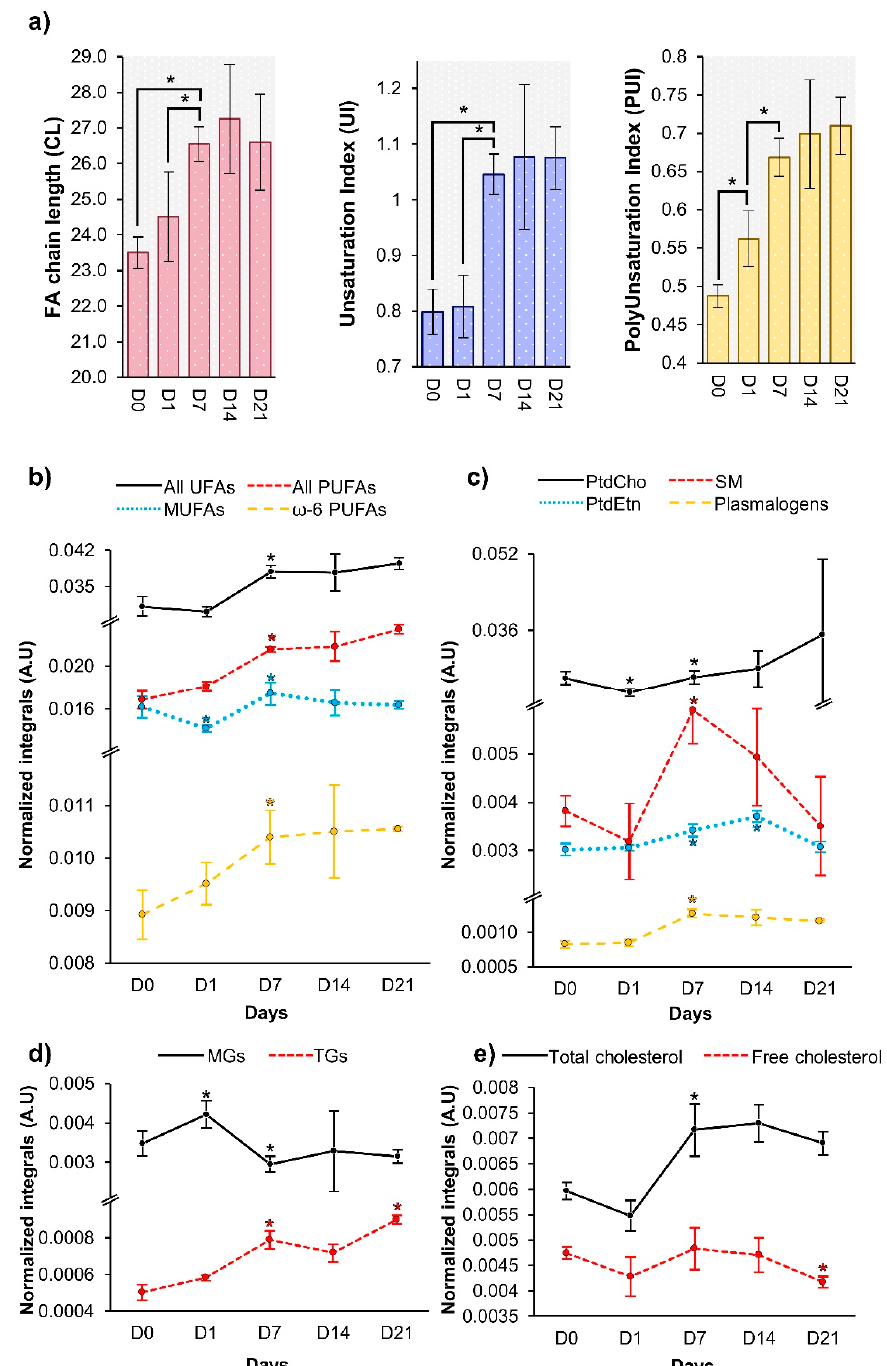
Figure 5. Average lipid characteristics ( a ) and level fluctuations ( b – e ) of lipid species/classes selected in Figure 4. ( a ) Average fatty acid chain length, unsaturation index and polyunsaturation index were calculated according to [55]. Normalized integrals of lipids during the 21 days of osteogenic differentiation, including ( b ) fatty acids, ( c ) glycerophospholipids and sphingomyelins, ( d ) cholesterol, and ( e ) glycerolipids. Abbreviations as defined in Figure 2. Di: day i; *: Wilcoxon Rank-sum p- value < 0.05 (specifically in ( b – e ) graphs, each day was compared to the previous timepoint).